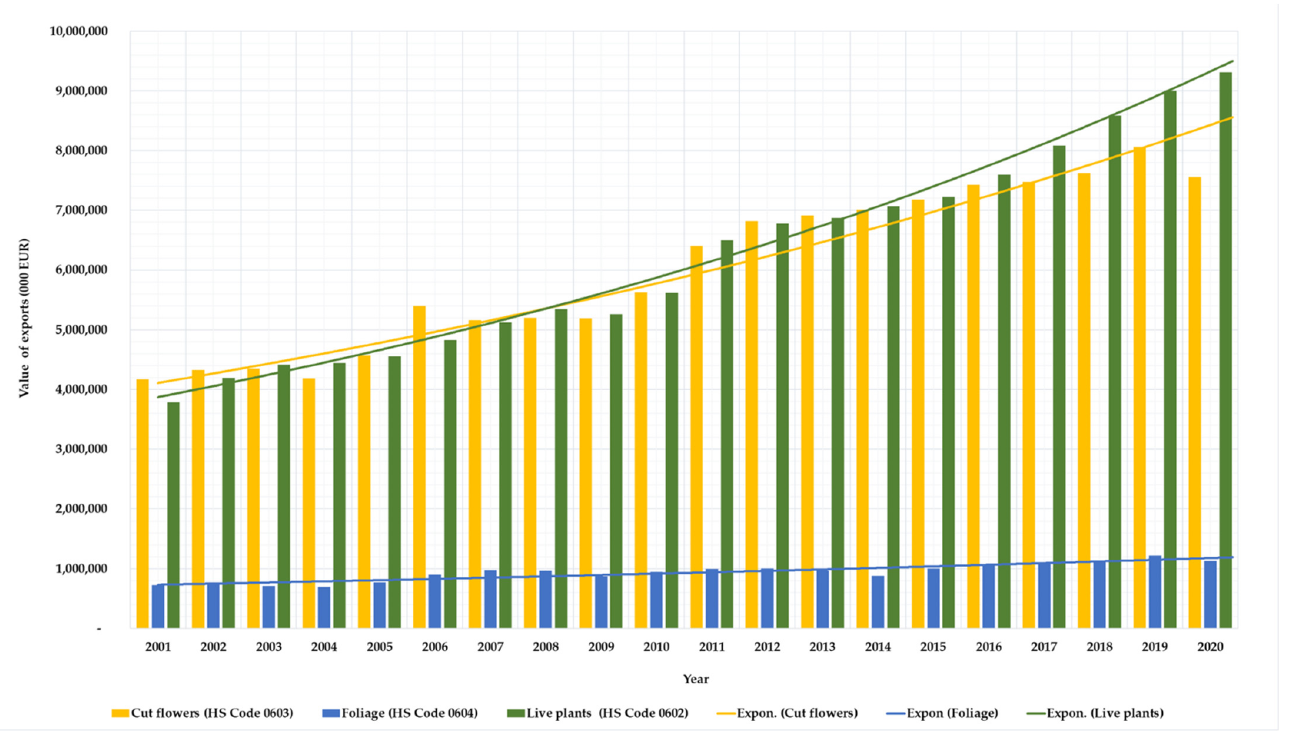
Figure 1. The international trade of flowers and ornamental plants: the trend of world exports (000 EUR, 2001–2020). Source: our elaboration on [51] (data extraction: 24th January 2022). The identified